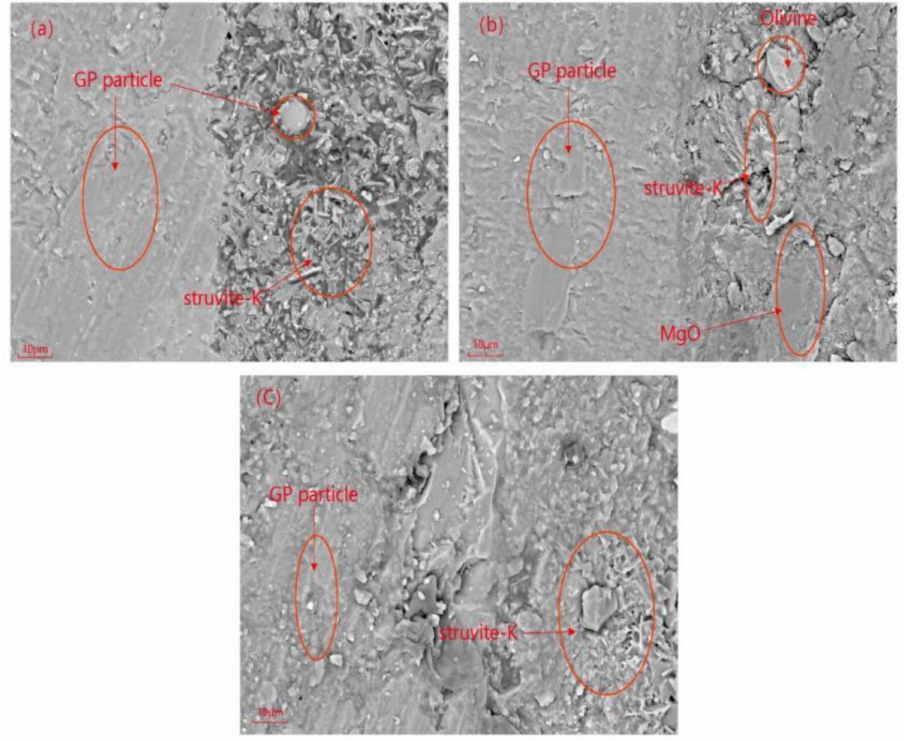
Figure 11. SEM images of the MPC pastes mixed with glass fragments: ( a ) M/P ratio = 1:1, 20%; ( b ) 2:1, 40%; ( c ) 3:1,